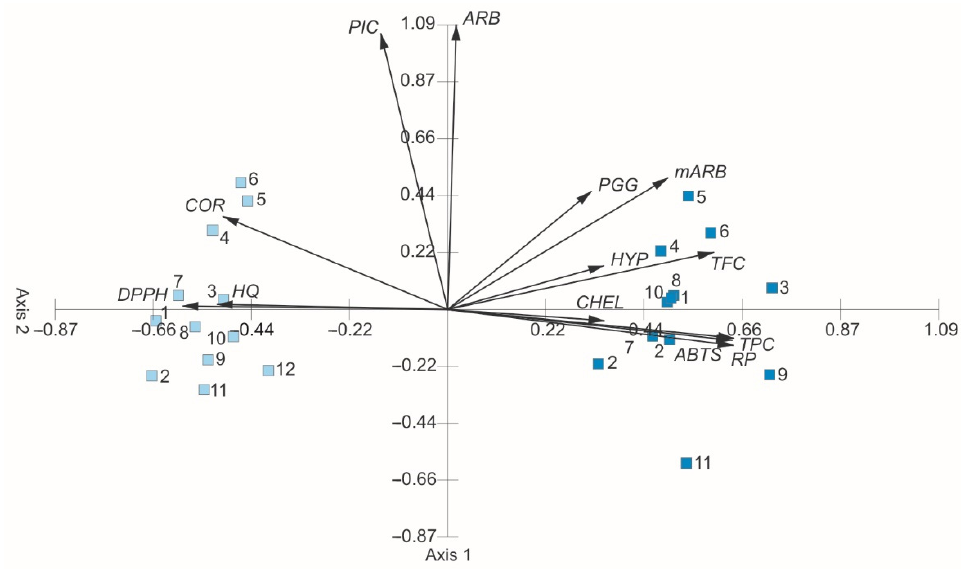
Figure 11. PCA ordination on the basis of the chemical composition of bearberry leaf extracts and antioxidant activity parameters. TPC—total phenolic concentration, TFC—total flavonoid concentration, ARB—arbutin, HQ—hydroquinone, mARB—methylarbutin, PGG—penta-O-galloyl- β -d-glucose, PIC—picein, COR—corilagin, HYP—hyperoside, ABTS—ABTS • + scavenging activity,